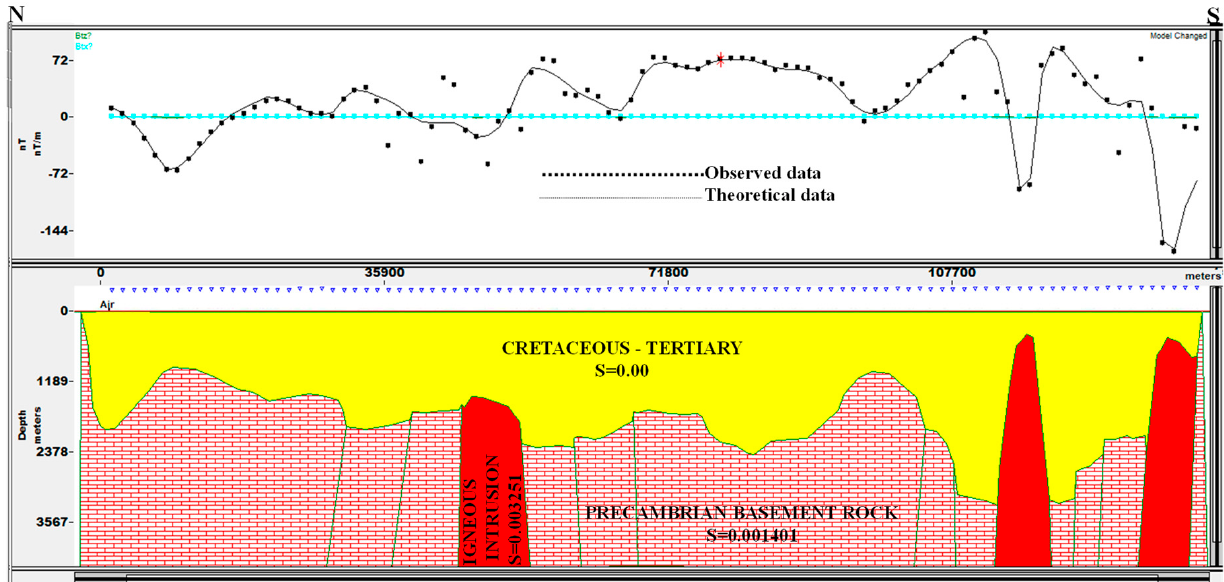
Figure 5. 2-D total magnetic intensity model obtained at Profile 1 showing thickness of sediments, basement and igneous rocks, and their respective susceptibility values.